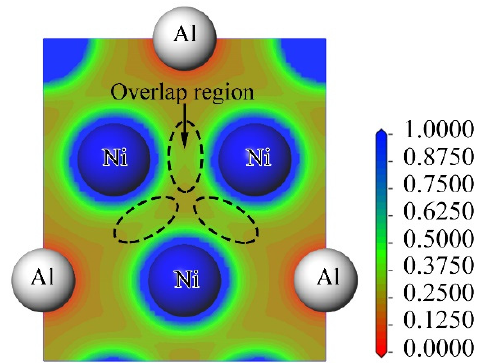
Figure 2. Distribution of electron density in the (111) crystal plane.